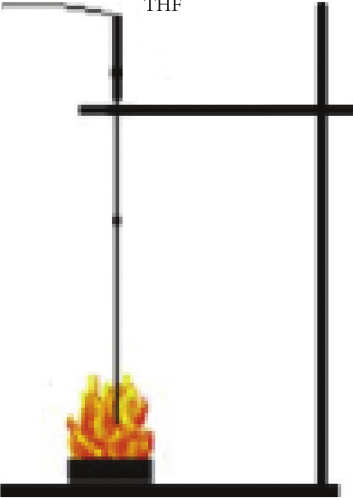
Figure 1: Device of free